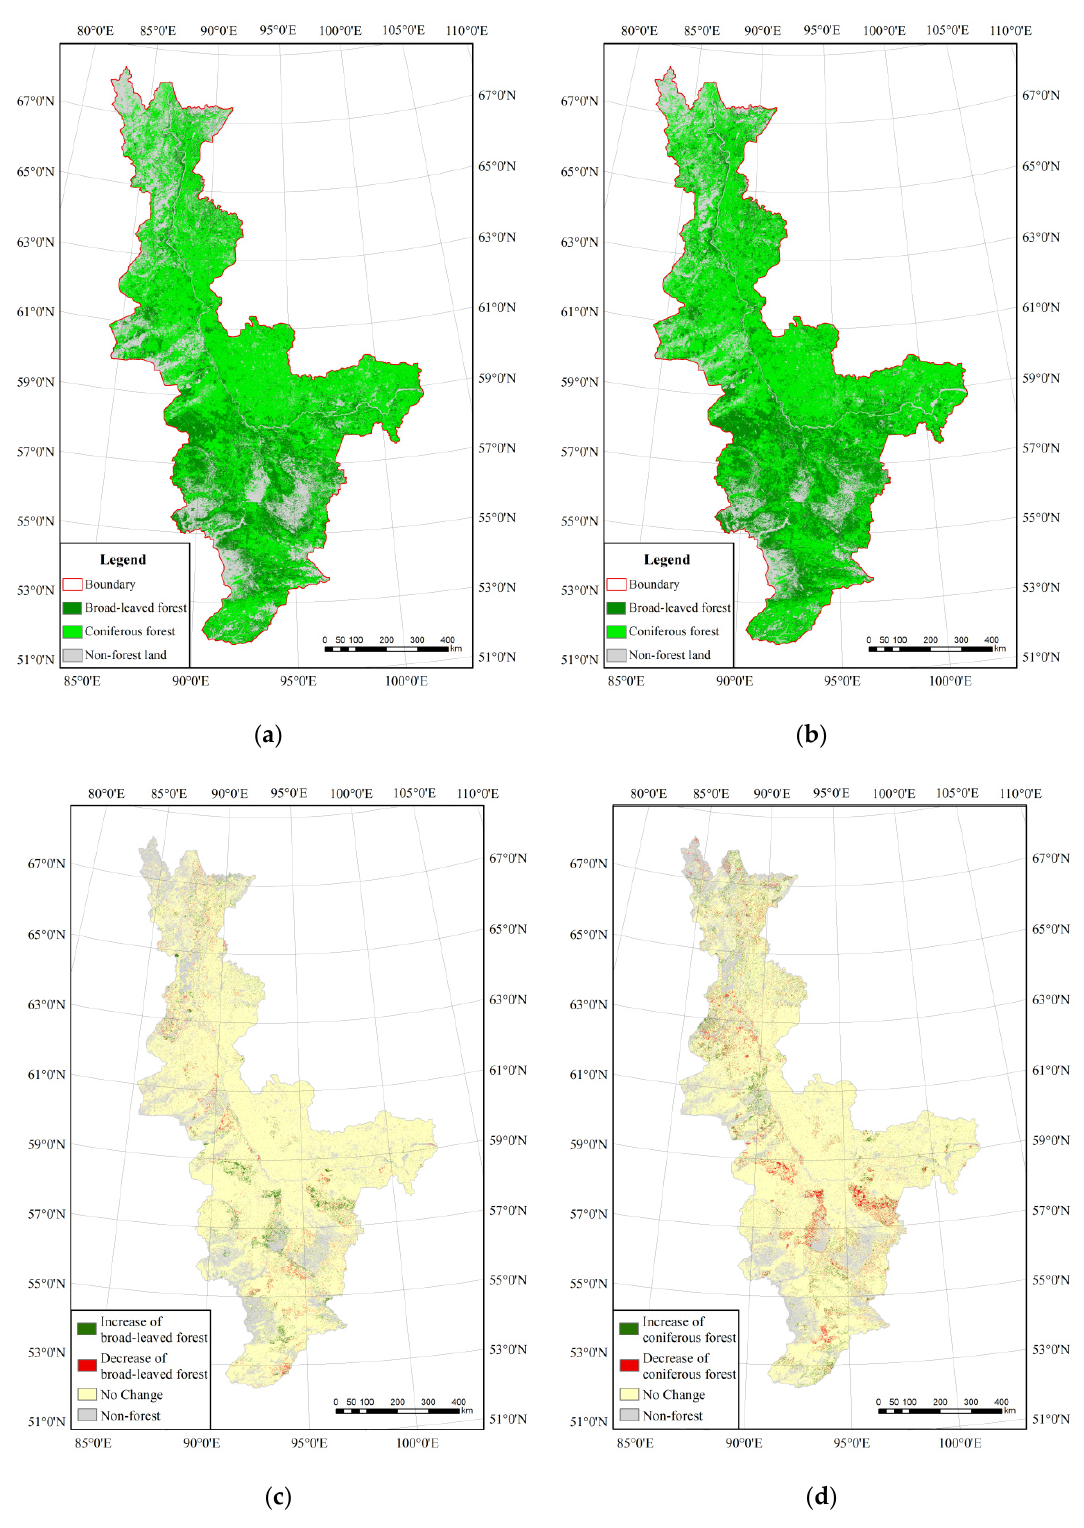
Figure 7. Broad-leaf forest and coniferous forest classification: ( a ) 1985; ( b ) 2015; ( c ) change in the broad-leaved forest; ( d ) change in the coniferous forest. Table 4. Broad-leaved forest area.